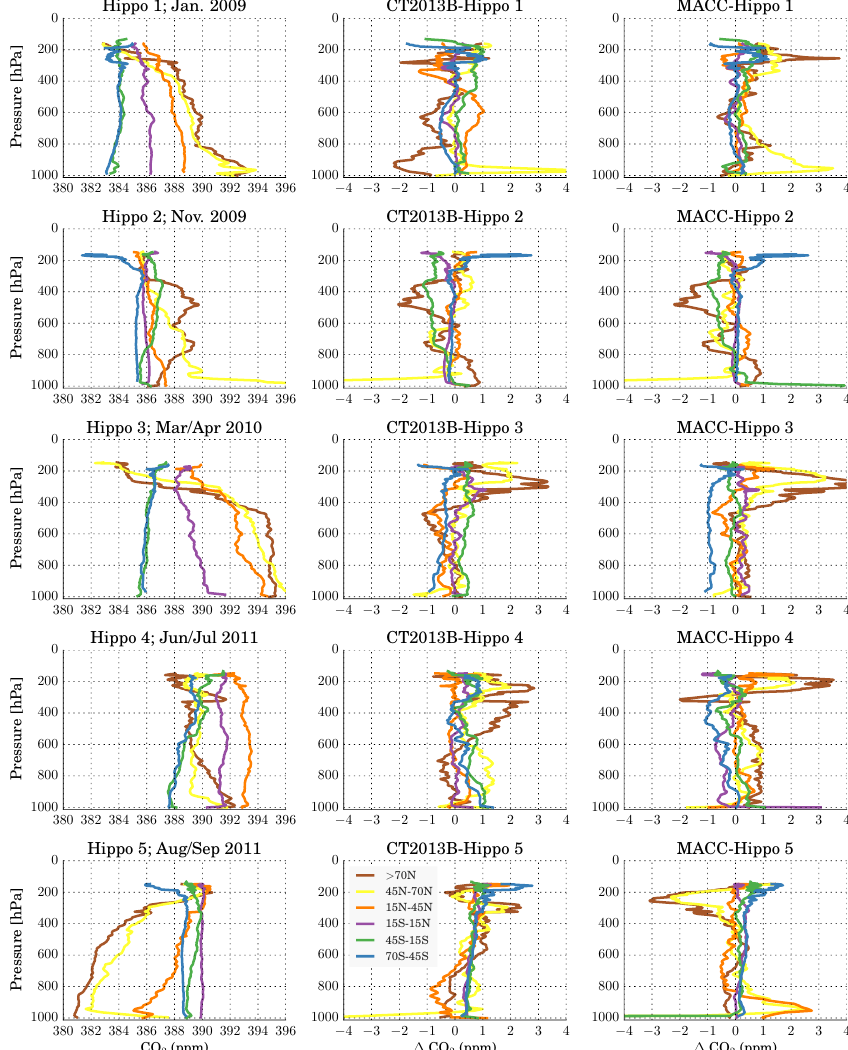
Figure 3. Summary of averaged CO 2 HIPPO profiles in ppm (left column) and model–HIPPO differences (middle and right column), separated by latitudinal bands (color coded) and HIPPO campaign (separate rows).